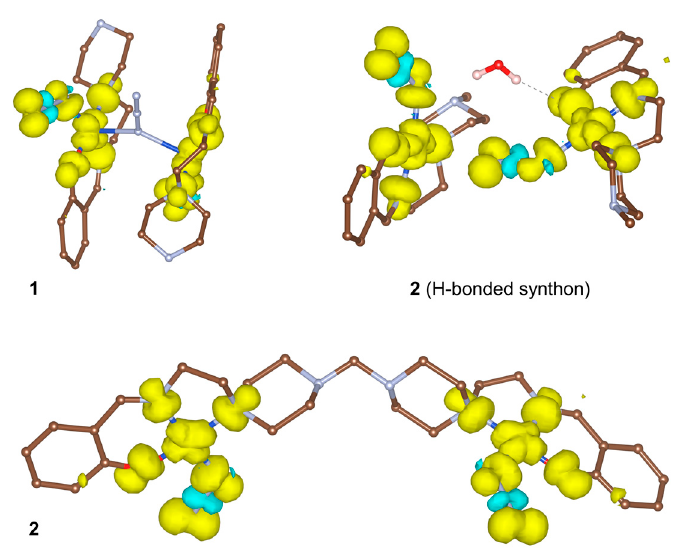
Figure 9. Isosurfaces of the DFT calculated spin densities for the triplet state of 1 and 2 (molecular dinuclear and H-bonded dimeric synthon) with a cutoff value of 0.002 e a 03 (yellow and blue correspond to a positive and negative density, respectively).